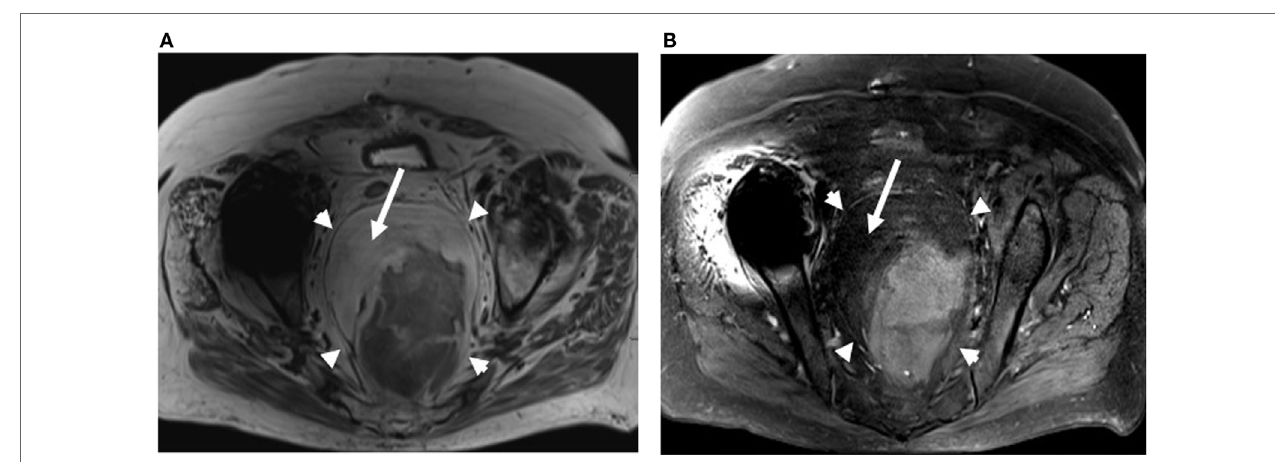
FiGURe 2 | Axial nonfat saturated (a) and fat saturated (B) T2-weighted MRI images of the pelvis also demonstrates a large fat containing mass within the presacral region (arrowheads). Bright fat on nonfat saturated image (a) saturates out on the fat saturated image (B) (arrows).